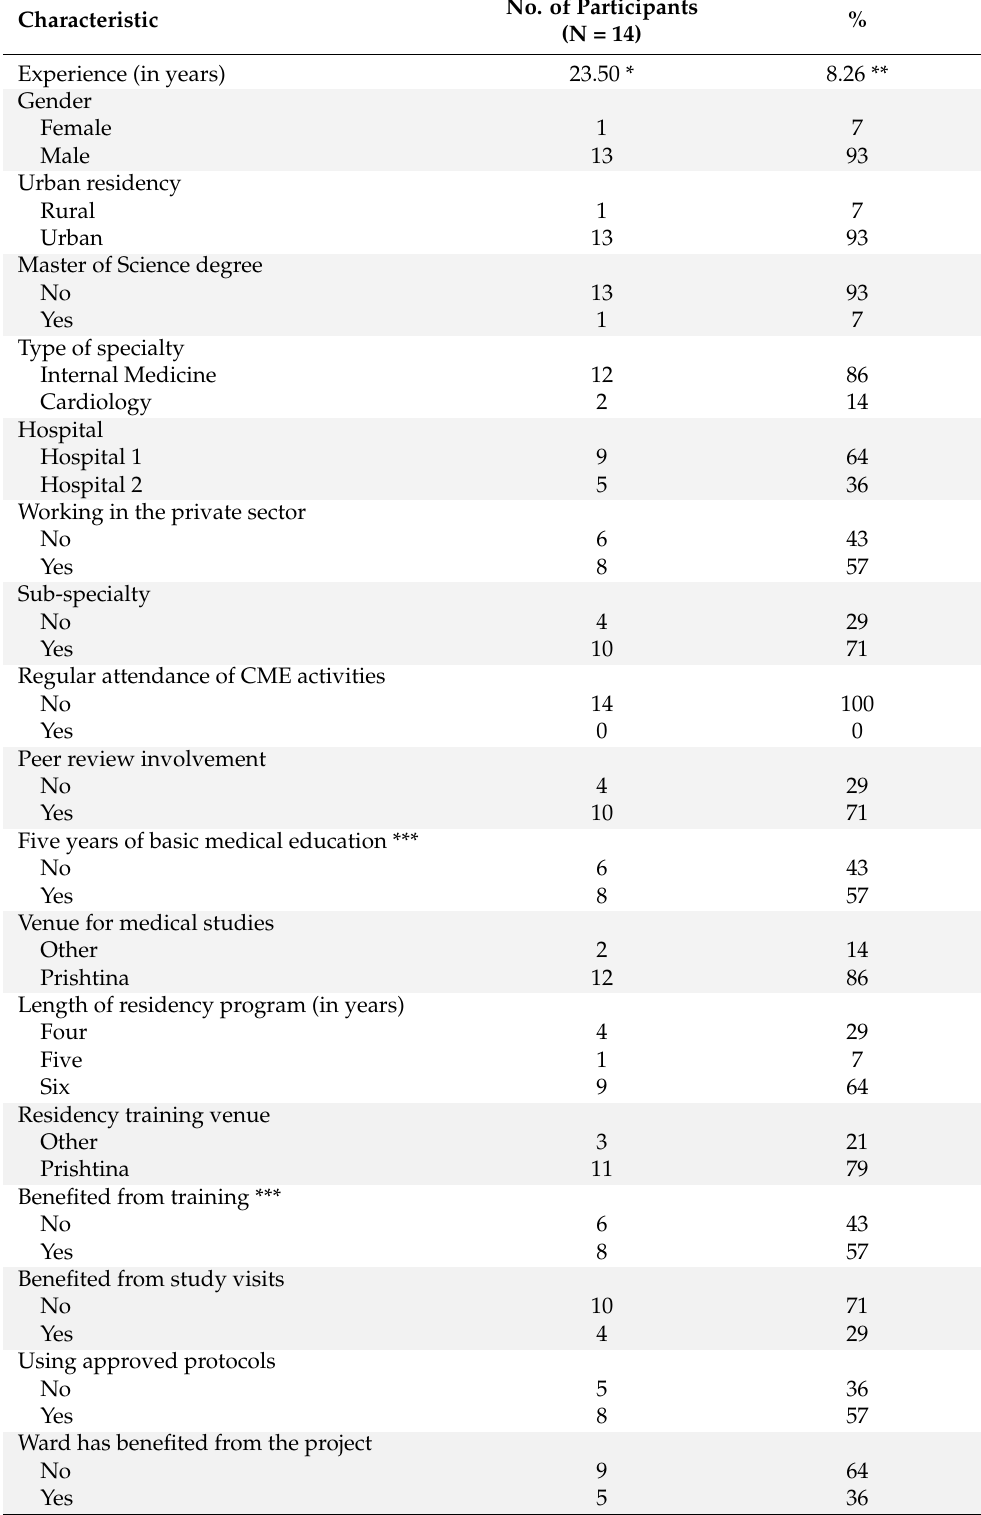
Table 1. Characteristics of the